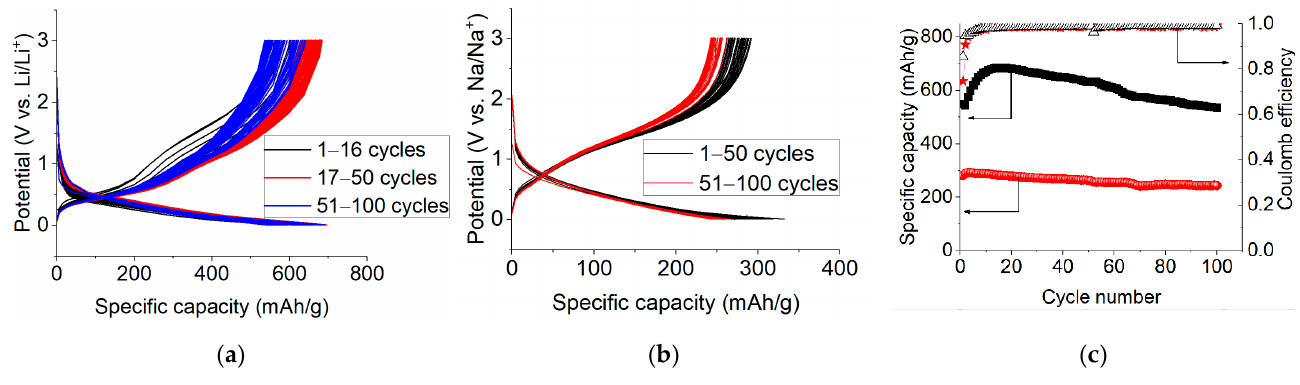
Figure 8. The performances of CoGe 2 P 0.1 upon long-term cycling at current density of 400 mA/g; ( a ) charge–discharge curves upon lithium insertion; ( b ) charge–discharge curves upon sodium insertion; ( c ) the capacity vs. current density dependence and Coulomb efficiency for insertion of lithium (black labels) and sodium (red labels).